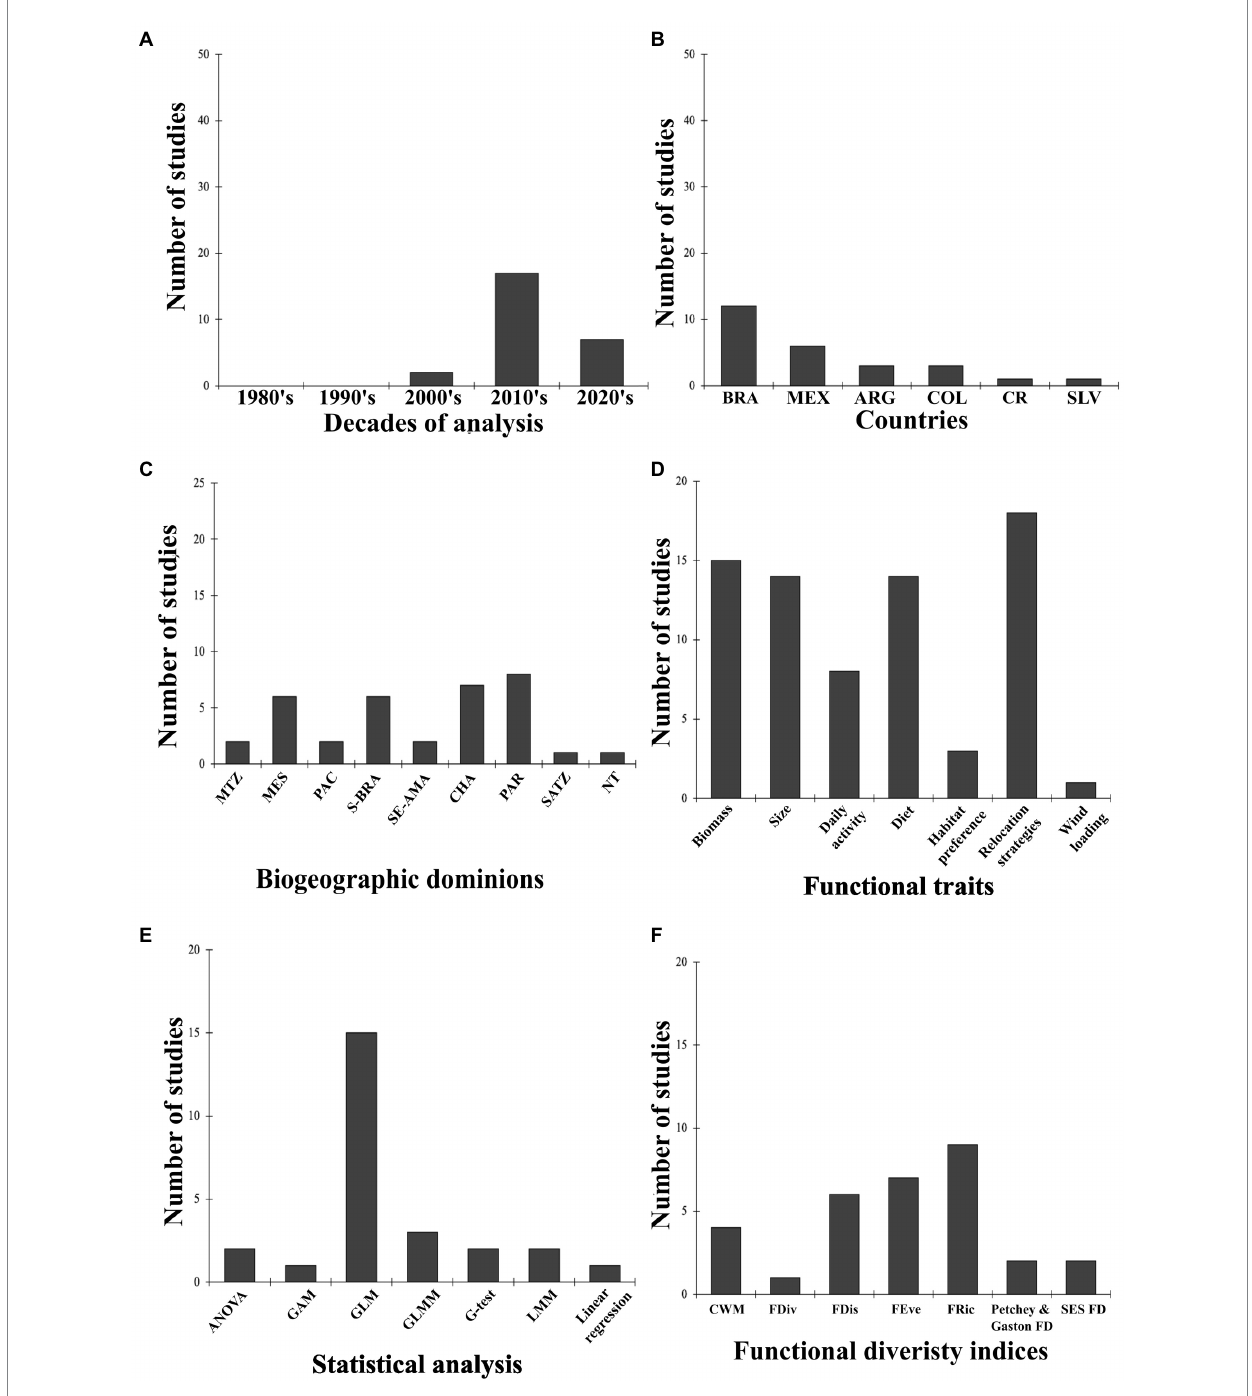
FIGURE 3 Number of functional diversity studies. (A) Over time (decades). (B) Per country. Brazil = BRA, Mexico = MEX, Colombia = COL, Costa Rica = CR, El Salvador = SLV, Argentina = ARG. (C) Per biogeographic dominion. Mexican Tranzition Zone = MTZ, Mesoamerican = MES, Pacific = PAC, Boreal Brazilian = B-BRA, SATZ = South American Transition Zone, South Eastern Amazonian = SE-AMA, Chacoan = CHA, Parana = PAR, Not tropical = NT. (D) Per functional trait. (E) Per statistical analysis. (F) Per functional diversity